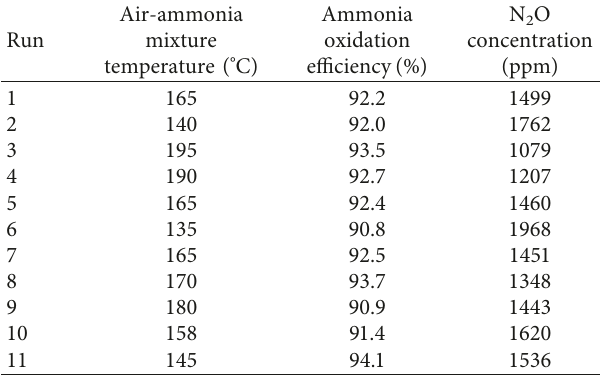
Table 1: Temperatures of air-ammonia mixture, ammonia oxi- dation efficiency, and N 2 O concentrations for the conducted